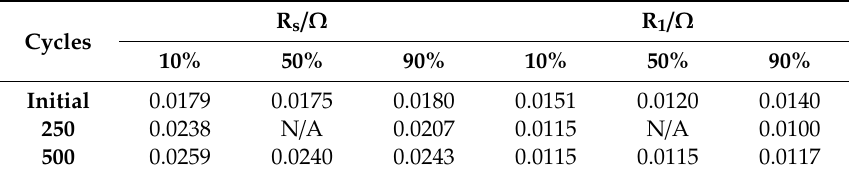
Table 1. Resistance Values Calculated While Fitting Equivalent Circuit.